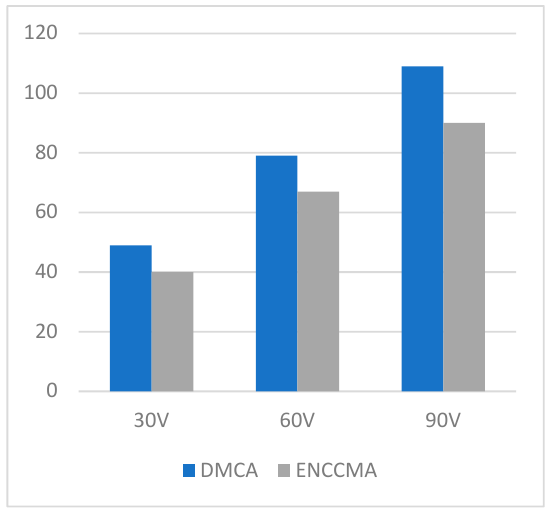
Figure 6. Data transmission for the city environment.